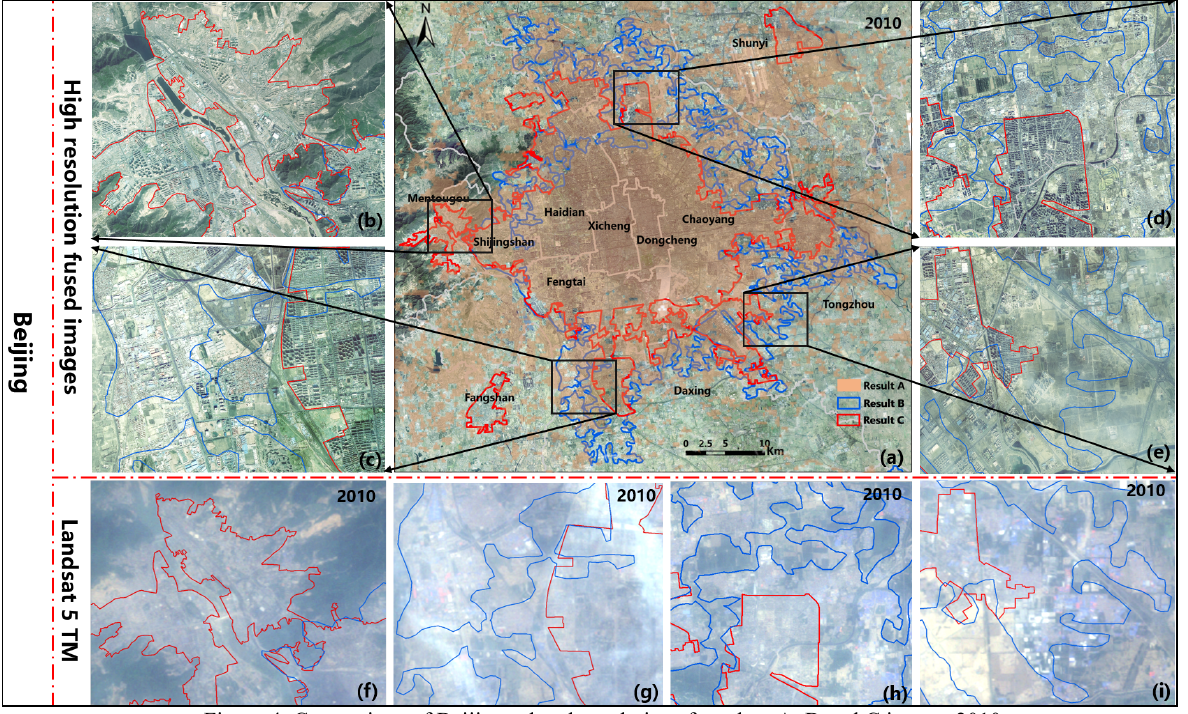
Figure 4. Comparison of Beijing urban boundaries of product A, B and C in year